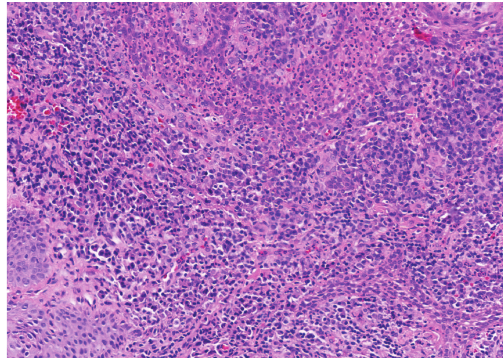
Figure 4: Polymorphic inflammatory infiltrate, predominantly chronic in the lamina propria and with granulocytes within the epithelium (H&E stain,